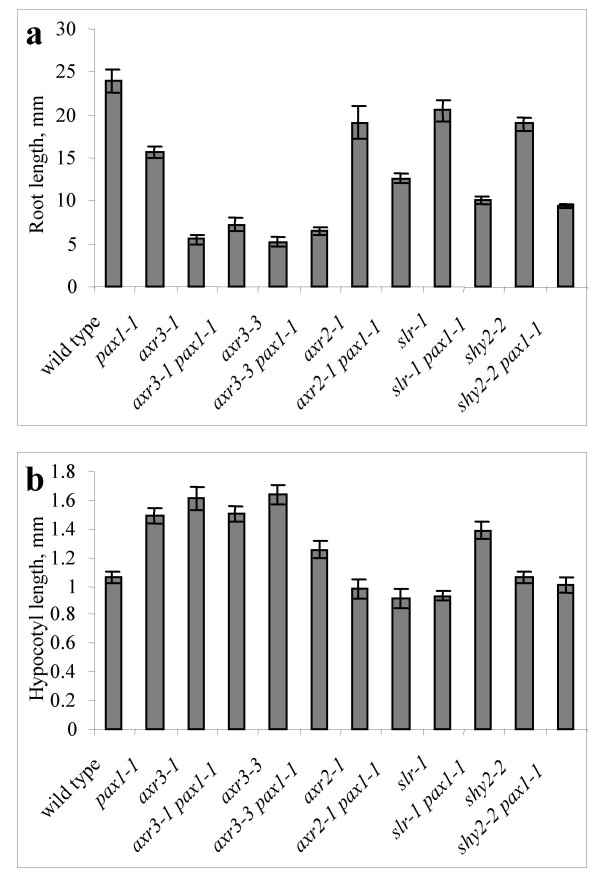
Double mutant analysis. (a) Root length. n ≥ 10. (b) Hypocotyl length. n ≥ 8. Measurements were taken 5 dag. Error bars represent SE.